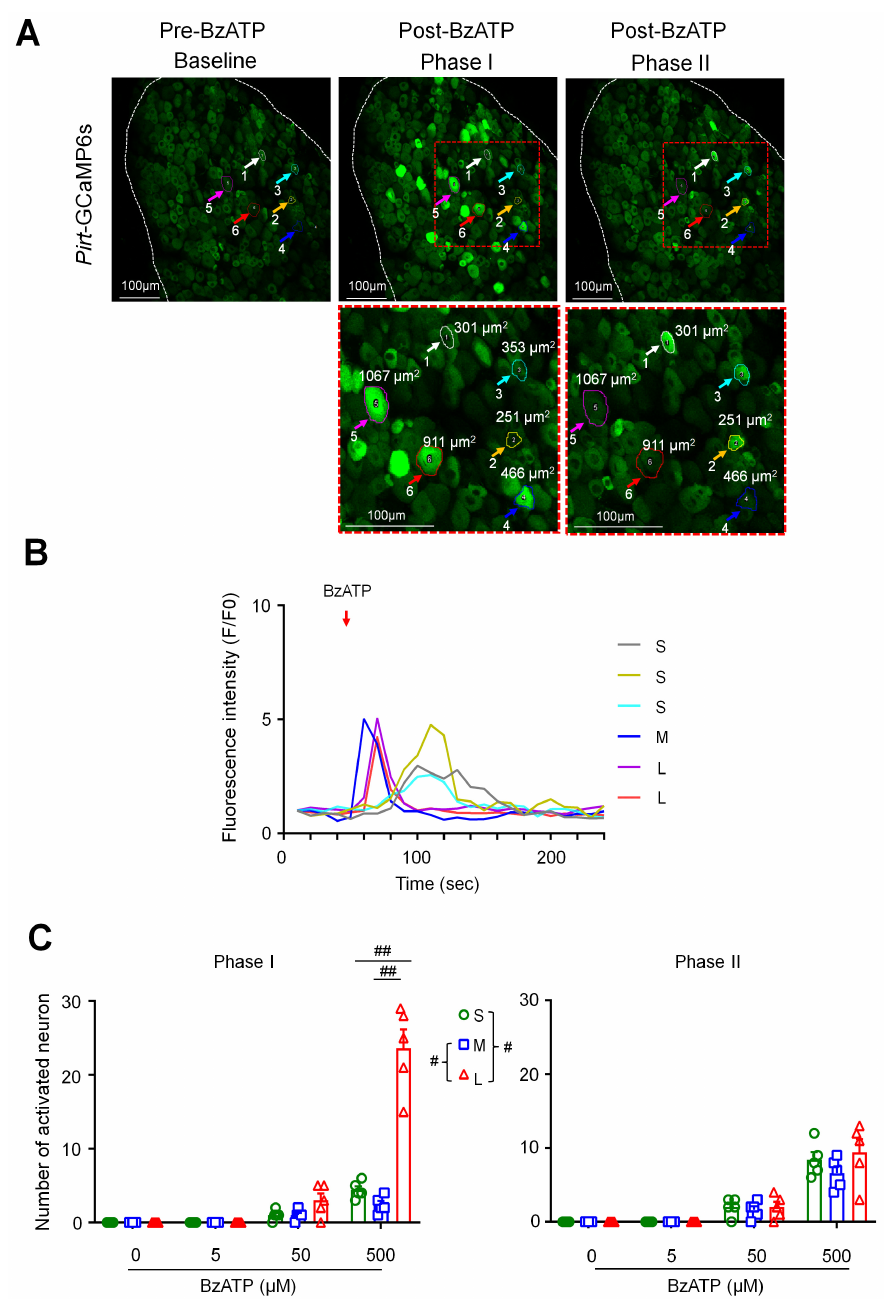
Figure 2. BzATP activates more large than small dorsal root ganglion (DRG) neurons in phase I. ( A ) Upper : Representative images showing changes in fluorescence intensity of L4 DRG neurons after ganglionic administration of BzATP (500 µ M) in Pirt -GCaMP6s mice during in vivo calcium imaging in anesthetized mice. Baseline (Frames (F)1–5, 10 s/frame), phase I (F6–7), and phase II post-drug (F8–26). Examples of activated neurons are marked by colored circles and arrows. Lower : The red-outlined areas in phase I and phase II image are shown at higher magnification. DRG neurons were categorized according to the somal area as <450 µ m 2 (small, S), 450–700 µ m 2 (medium, M), and >700 µ m 2 (large, L). ( B ) Fluorescence intensity traces (F/F 0 ) of selected neurons activated by BzATP in ( A ). Red arrow indicates the time of drug application. ( C ) Number of neurons in each subpopulation that were activated by BzATP (5, 50, 500 µ M, n = 6 mice) in phase I (F6–7) and phase II (F8–26). Data are expressed as mean ± SEM. # p < 0.05, ## p < 0.01 versus indicated group. Two-way mixed-model ANOVA with Dunnett’s multiple comparisons